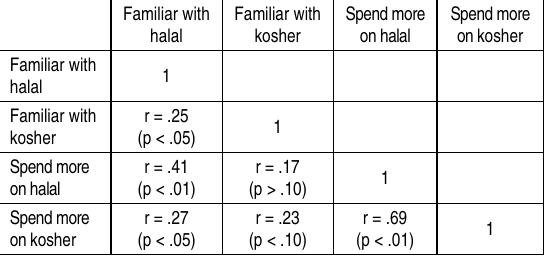
Table 1. Familiarity and willingness to spend on halal and kosher – correlations